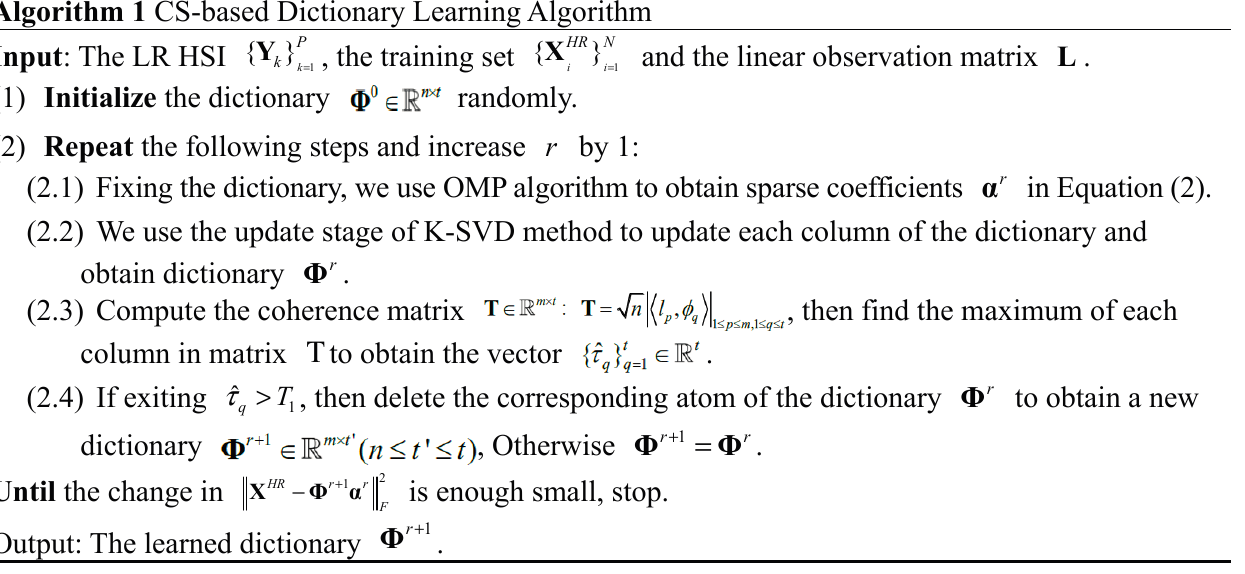
Algorithm 1 CS-based Dictionary Learning